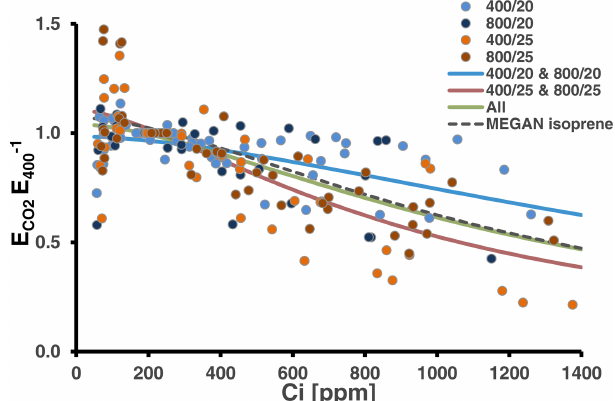
Figure 4. Relative MT emission rates (normalized to the initial mea- surement at 400ppm CO 2 ) measured during CO 2 ramping at the as- say temperatures of 30 ◦ C (26 response curves). Colors of the dots denote the CO 2 and temperature regimes, in which plants have been grown. Solid lines present best fits to the algorithm of the MEGAN modeling framework accounting for the short-term effect of CO 2 on isoprene emissions (Eq. 1). The green line shows the fit from all data and the red and blue lines from the warm- and cool-grown plants, respectively. The dashed black line depicts the CO 2 scaling currently used in MEGAN (Guenther et al., 2012). All coefficients values and additional information are given in Table S4 of Supple- ment